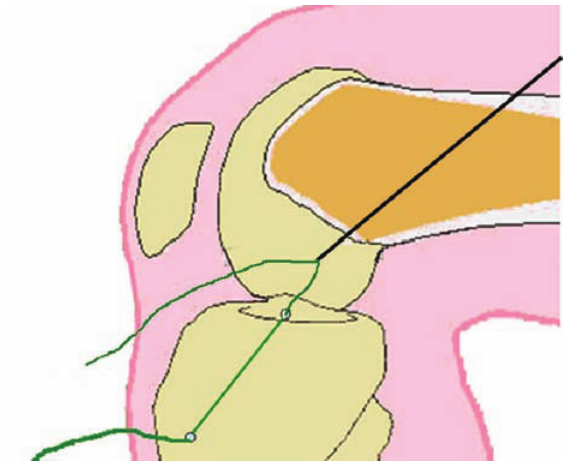
Figure 3 - Rigid body with reflective spheres for the navigation–linked pointer.